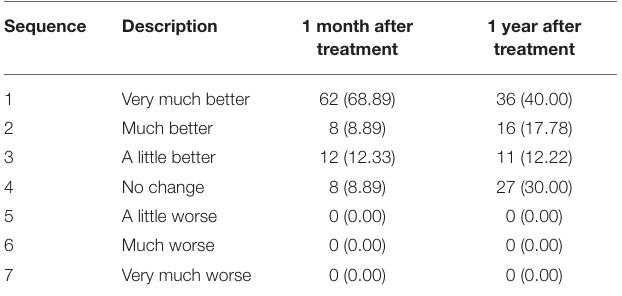
TABLE 2 | The Patient Global Impression of Improvement (PGI-I) at 1 month and 1 year after treatment with Modified Buzhong Yiqi Decoction ( n = 90). Choose a number that best described the condition of the patient’s urethra after treatment compared to before the patient started